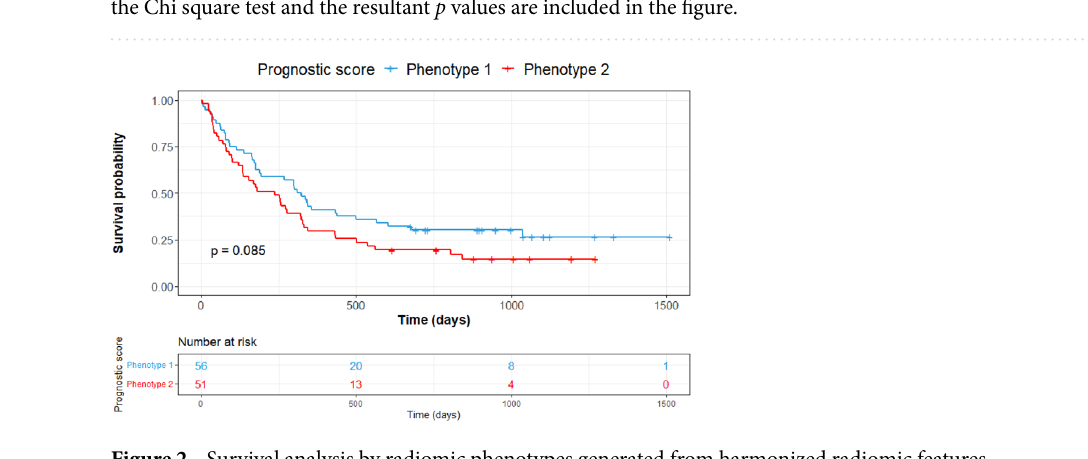
Figure 2. Survival analysis by radiomic phenotypes generated from harmonized radiomic